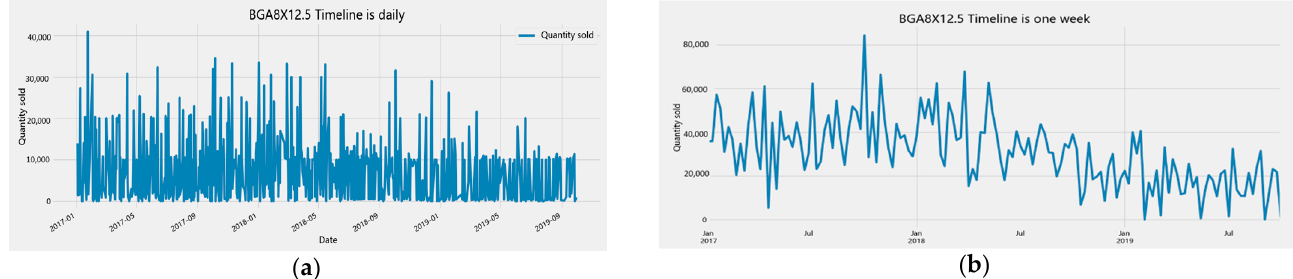
Figure 3. Timeline conversion of the difference graph. ( a ) BGA8X 12.5 timeline is daily; ( b ) BGA8X 12.5 timeline is on week.